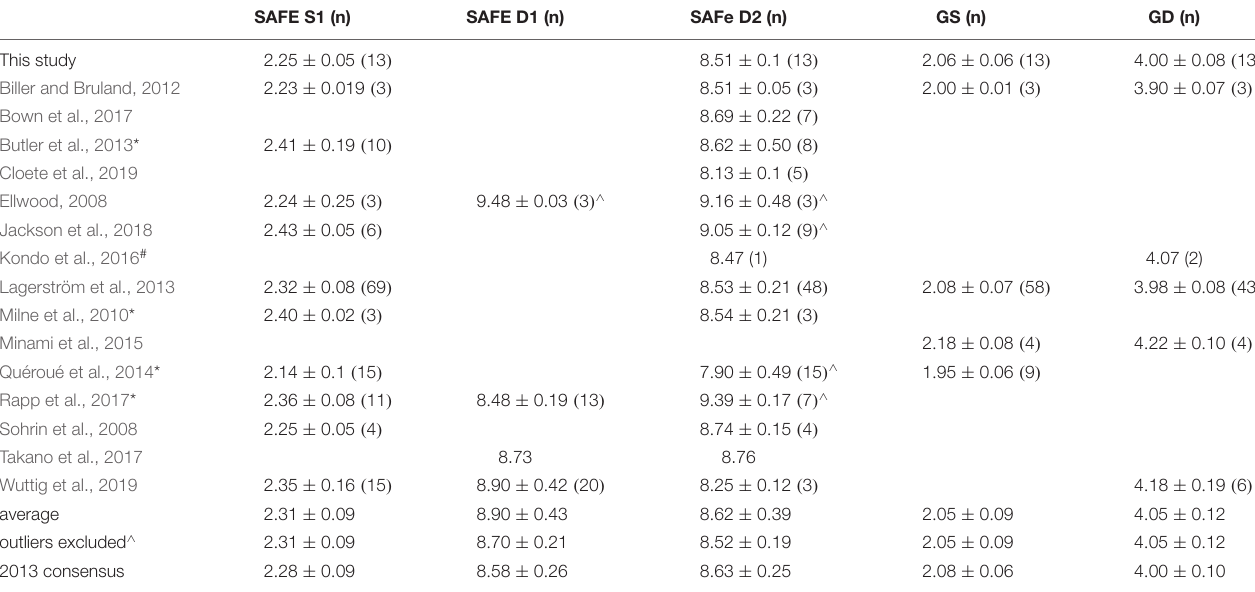
TABLE 1 | Concentrations of Ni (nmol kg − 1 ) for reference samples (GEOTRACES and SAFe) as obtained in this study as well as a compilation of previously reported values and the 2013 consensus values as reported on the GEOTRACES website